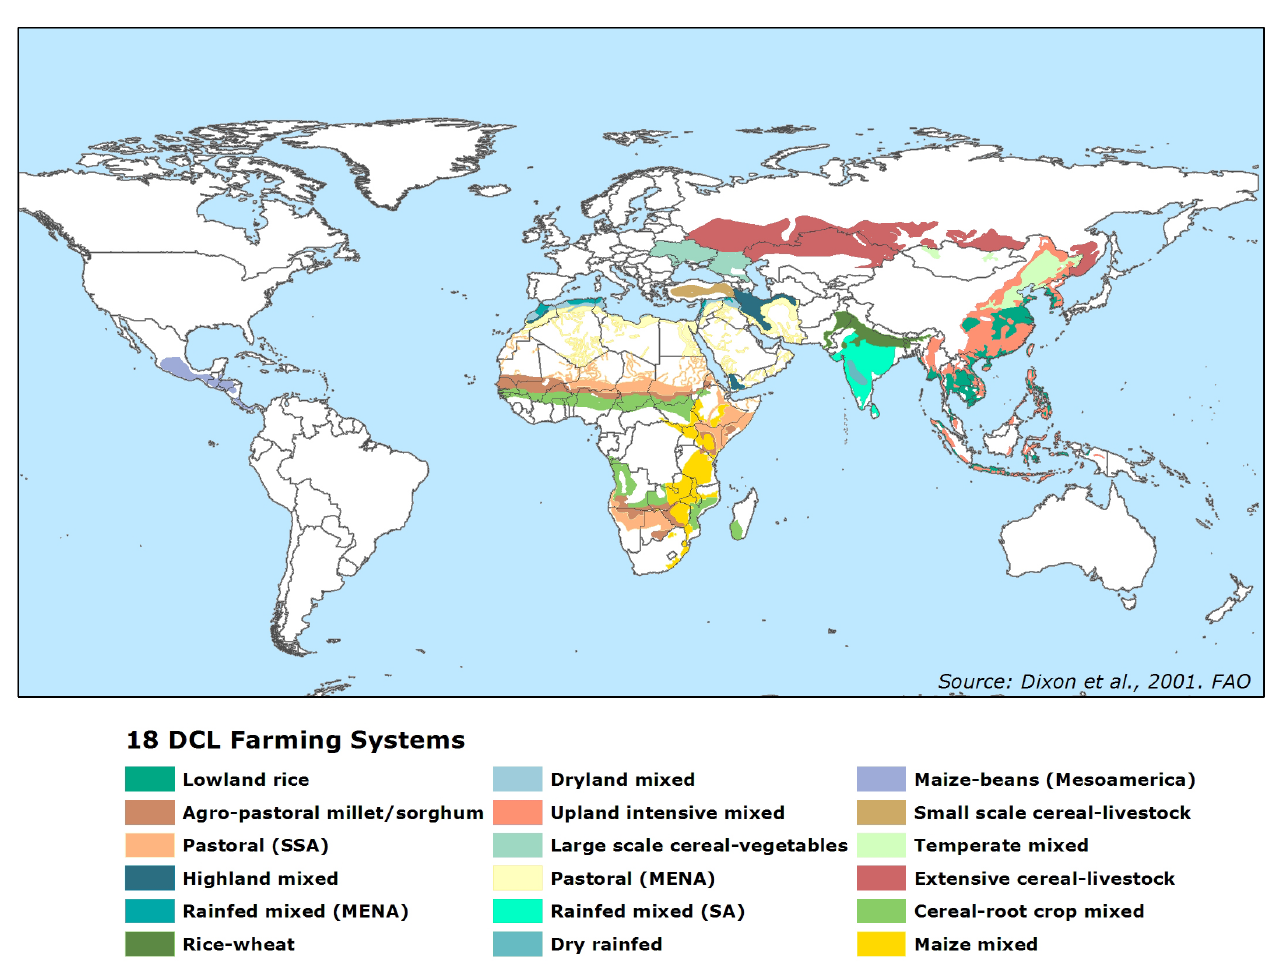
Figure 1. 18 priority dryland cereal and legume priority farming systems